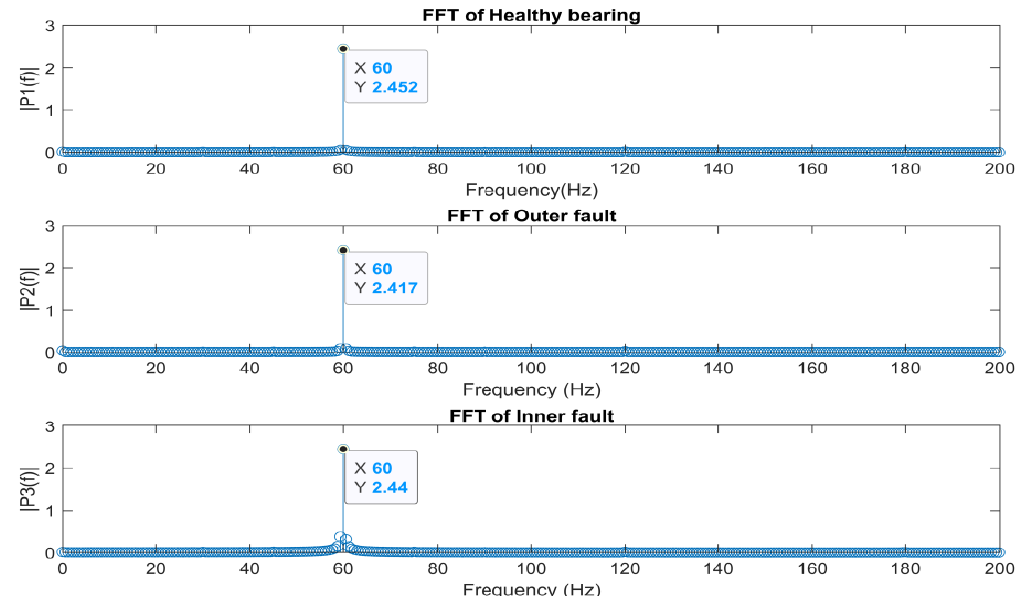
Figure 3. Frequency domain representation of different bearing conditions.